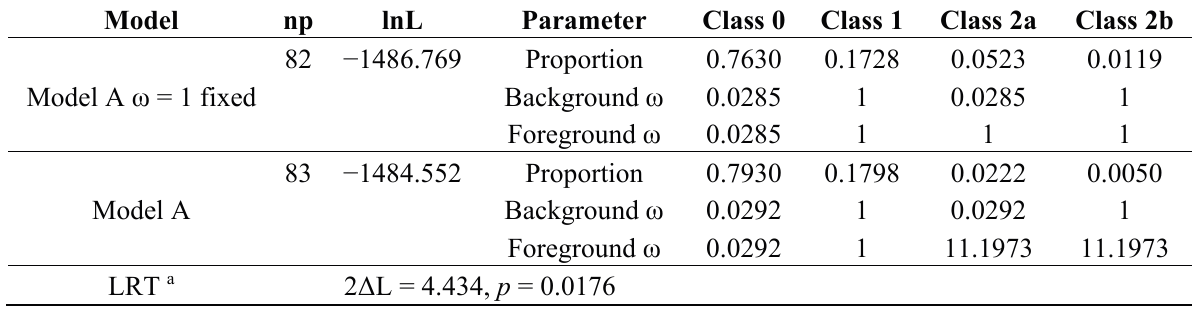
Table 6. Results of branch-site model analysis and the likelihood ratio tests for the foreground branch MYB19 .